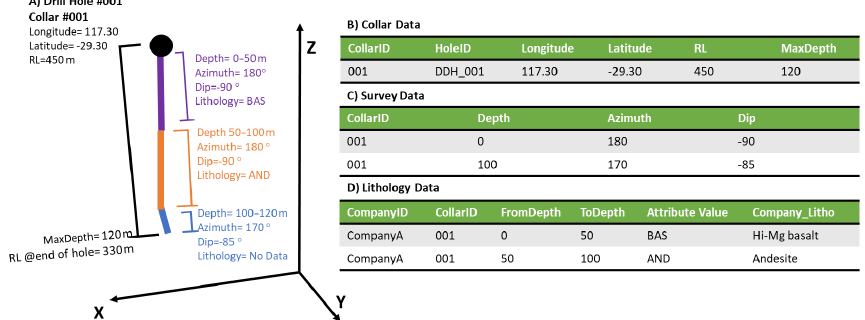
Figure B1. Simplified example of a drill hole (1.A) and its corresponding interval tables collar (1.B), survey (1.C) and lithology (1.D). The black circle denotes the collar location of the drill hole which is obtained from a collar table (1.B). The purple line represents the first downhole interval taking its deviation data from the survey table (1.C) and the lithology information from the lithology table (1.D). The same applies for the second interval (orange line) and the third interval (blue line). The orange line follows the same trajectory as the first interval as it uses the same entry in the survey table (1.C). The blue line has no lithology data as this information is not present in the lithology table (1.D). The MaxDepth denotes the total drill length (1.B).